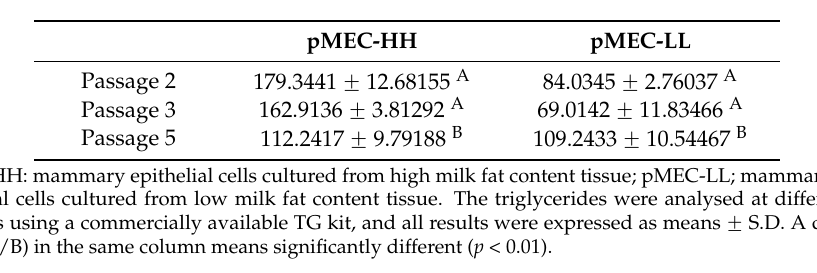
Table 1. TG contents in two different bovine mammary epithelial cells (MEC, µ